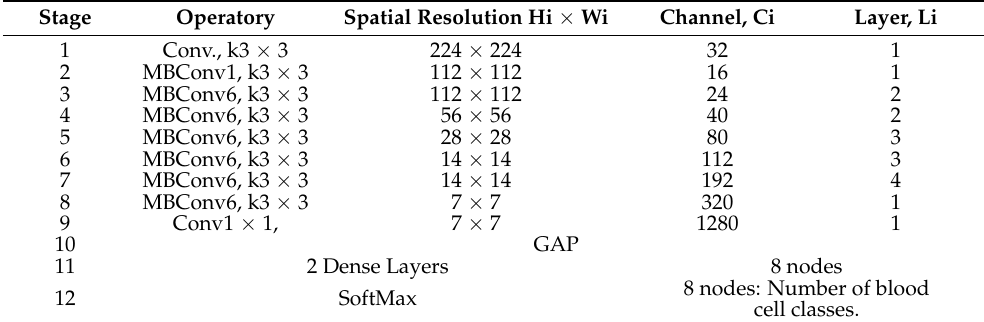
Figure 4. Feature extraction methodology of the proposed BCNet framework. Table 1. Technical Parameters of the proposed BCNet network.